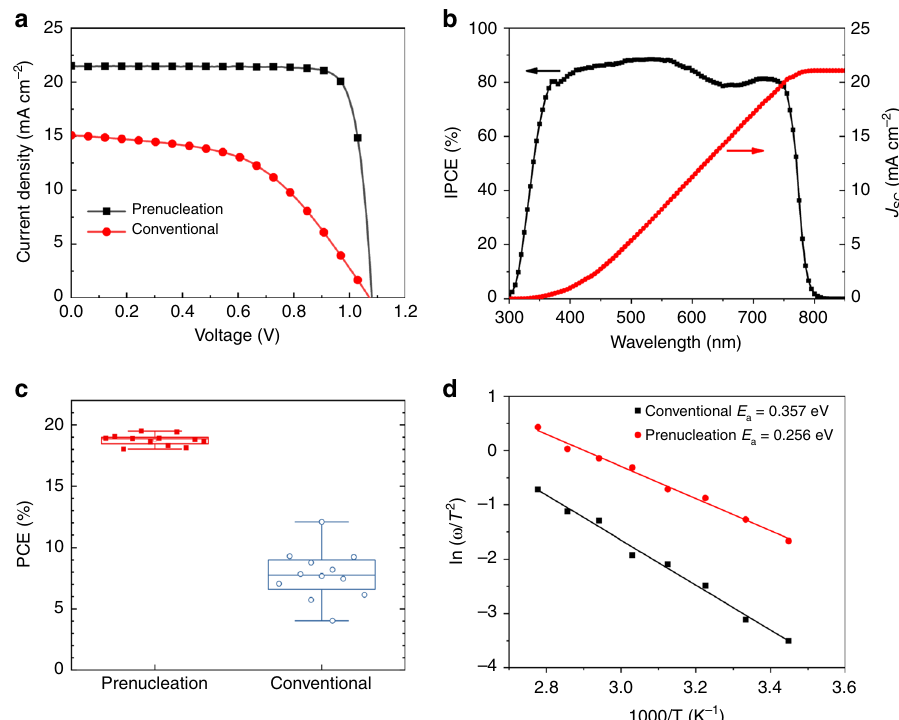
Fig. 4 The performance of PVSCs fabricated in ambient atmosphere. a Current density versus voltage ( J - V ) curves of PVSCs made with perovskite fi lms fabricated using the prenucleation method (black) and the conventional method (red). b IPCE curve (black) and integrated current density ( J sc ) curve (red) of the PVSC fabricated by the prenucleation method. c The statistical data of PVSCs fabricated using the perovskite fi lms prepared by the prenucleation method (red) and the conventional method (blue). In the Box-Whisker Plots, the middle line refers to the median (the second quartile), the box goes from the fi rst quartile to the third quartile, the upper/lower whisker refers to the maximum/minimum values of the data points. d The Arrhenius plots of the characteristic transition frequencies of PVSCs fabricated by the prenucleation method (red dots) and conventional method (black squares) and the corresponding calculated trap states energy